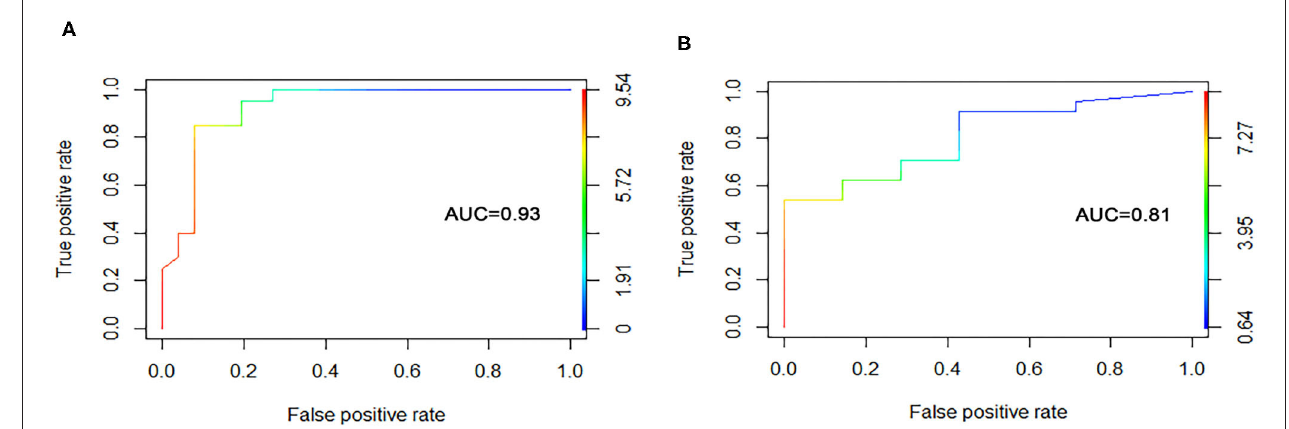
FIGURE 5 | The ROC curve of the predictive model. (A) Training dataset. (B) Validation